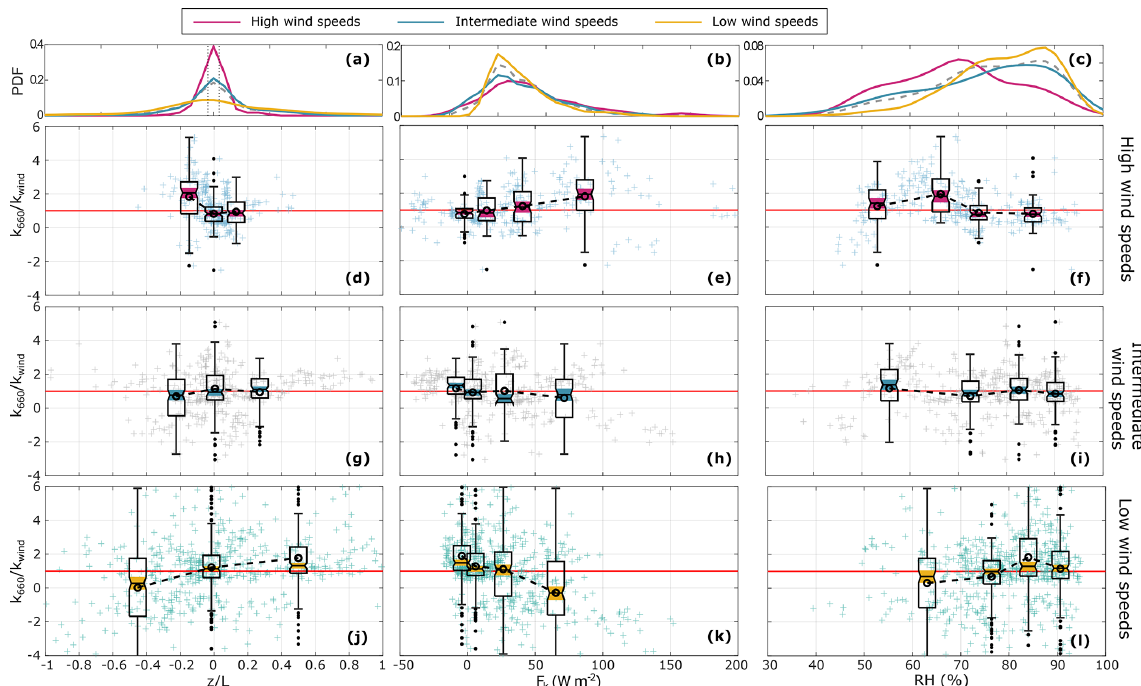
Figure A3. Same as in Fig. A1 for atmospheric control mechanisms: atmospheric stability (left), total enthalpy flux (centre), and relative humidity